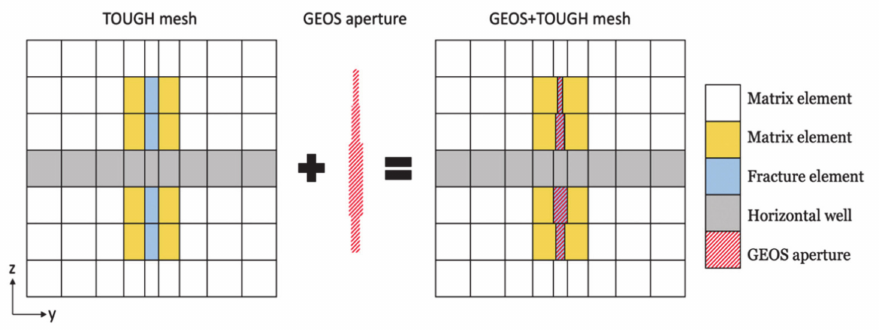
Figure 2. Example of fracture meshing and refinement based on GEOS-derived